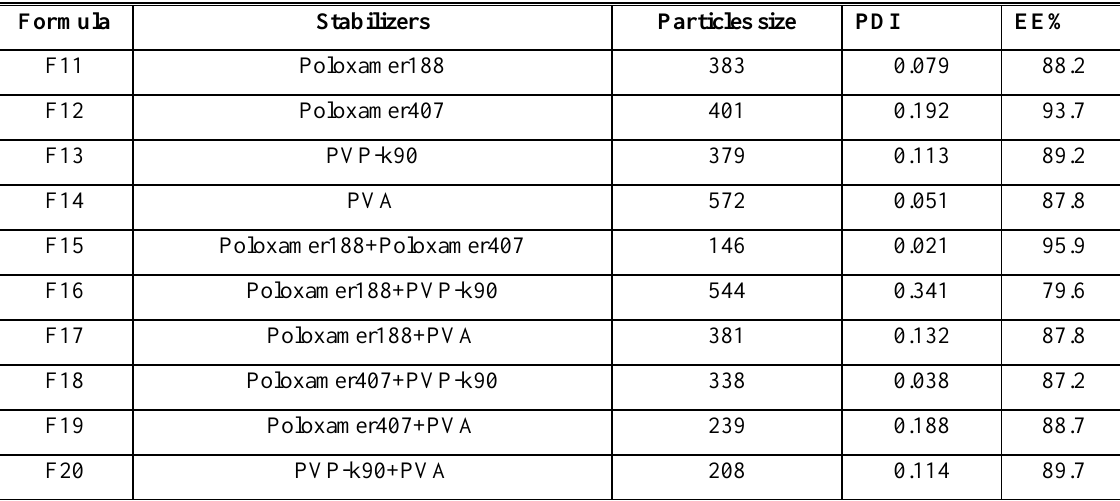
Table 5. Particle size, PDI and EE% of formulas at drug: stabilizer ratio